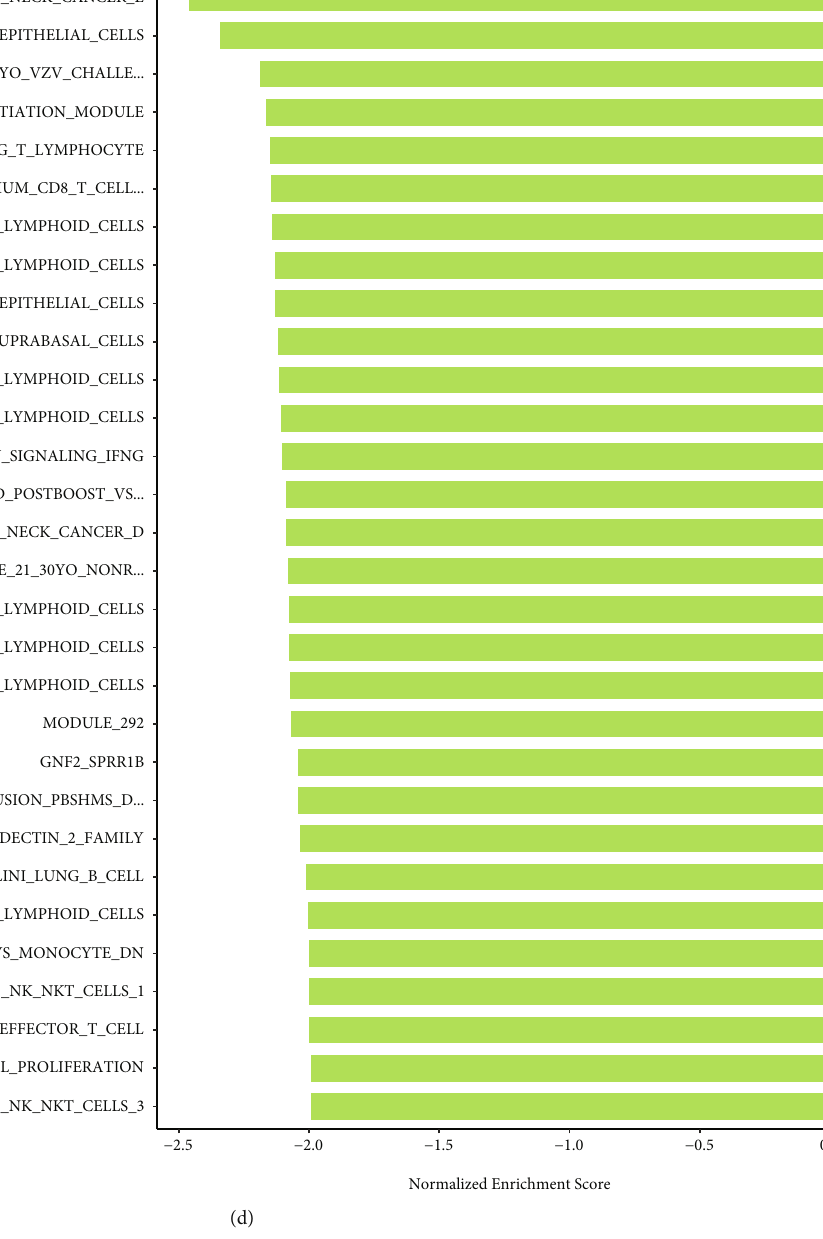
Figure 11: Histogram of GSEA functional enrichment analysis in high-risk group and low-risk group. (a) Enrichment analysis of high-risk groups in train set of TCGA. (b) Enrichment analysis of low-risk groups in train set of TCGA. (c) Enrichment analysis of high-risk groups in GSE44001. (d) Enrichment analysis of low-risk groups in